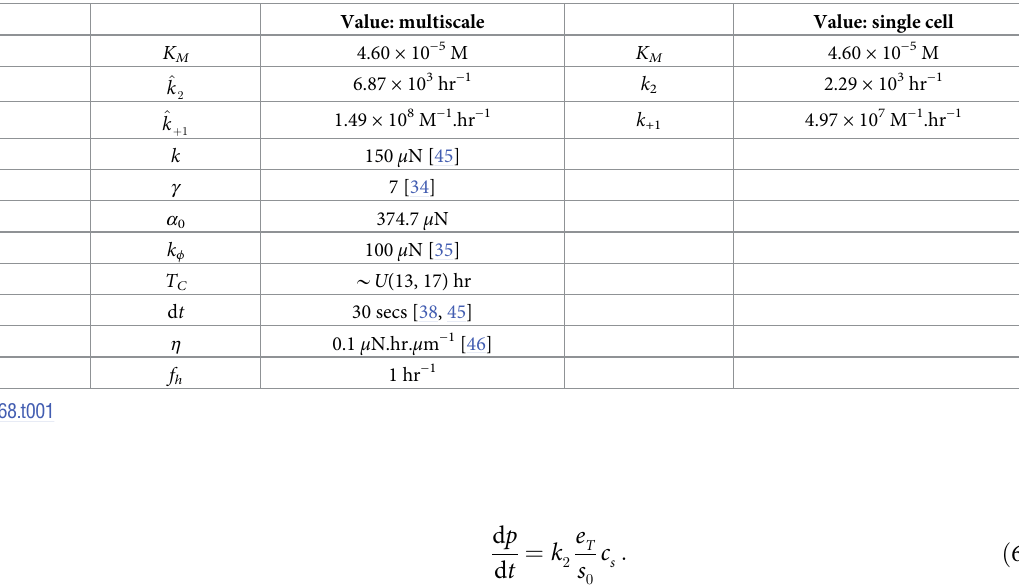
A full derivation of the model is given in the Methods section, and parameters are given in Table 1.